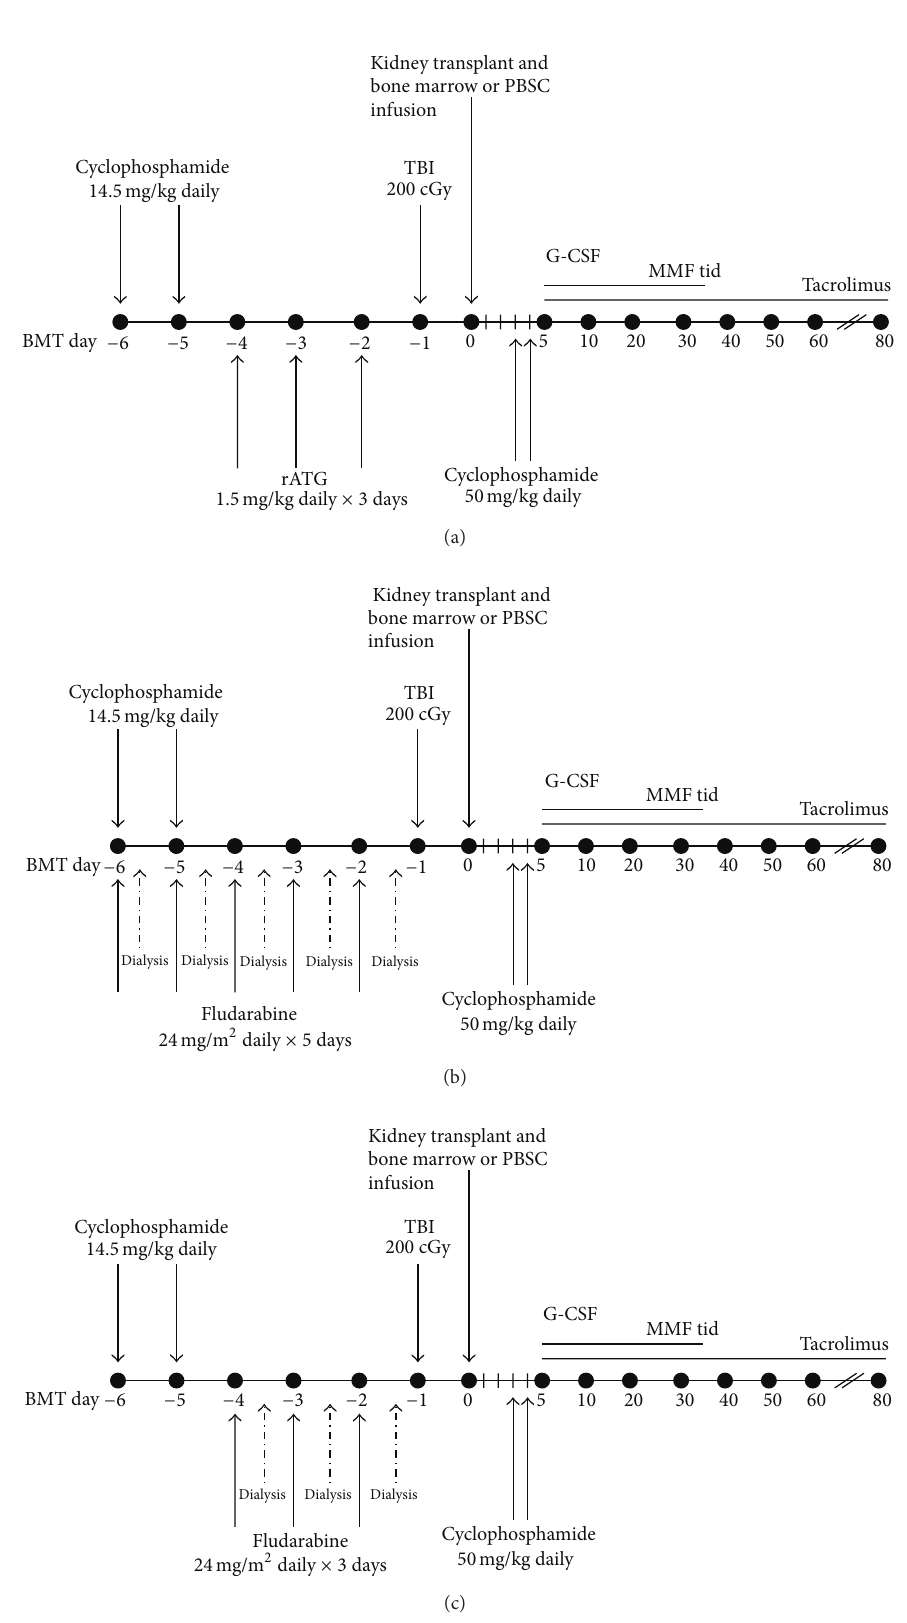
Figure 2: Schema for the 3 different versions (a, b, and c) of reduced intensity combined bone marrow and kidney transplantation using a haploidentical